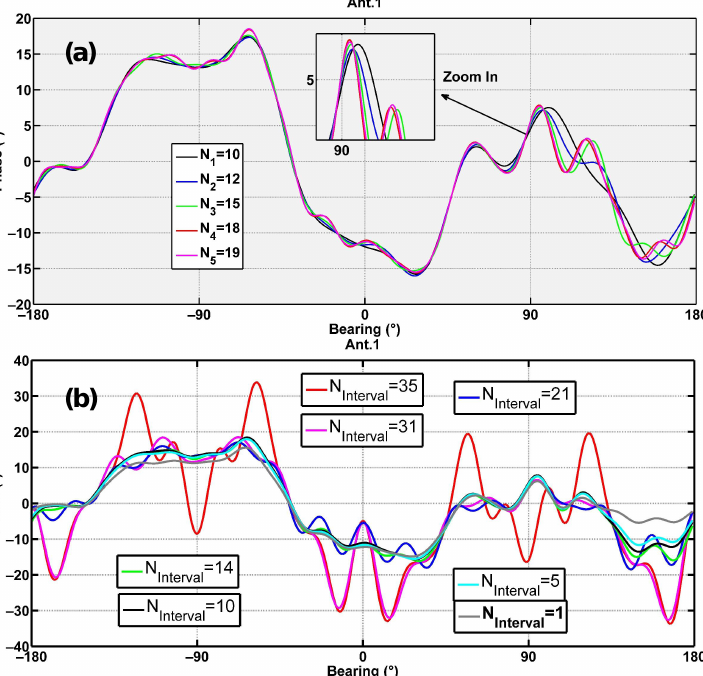
Figure A2. Phase pattern of Ant. 1: ( a ) versus the total number N of Fourier series; ( b ) versus the angular interval N interval